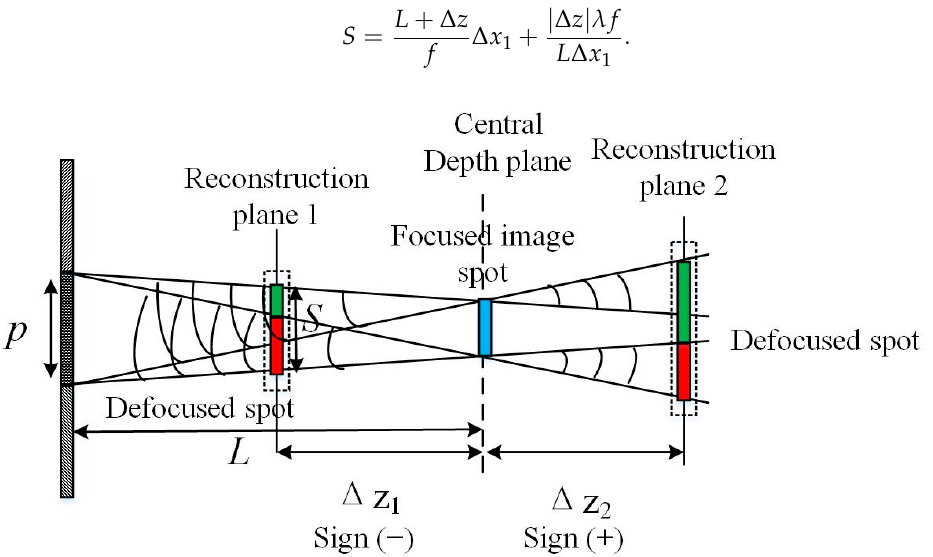
Figure 2. The image spot size at different reconstruction planes.